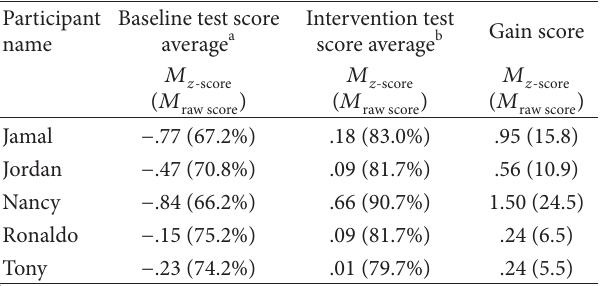
T 5: Biology test performance gain scores observed in Cleary et al.